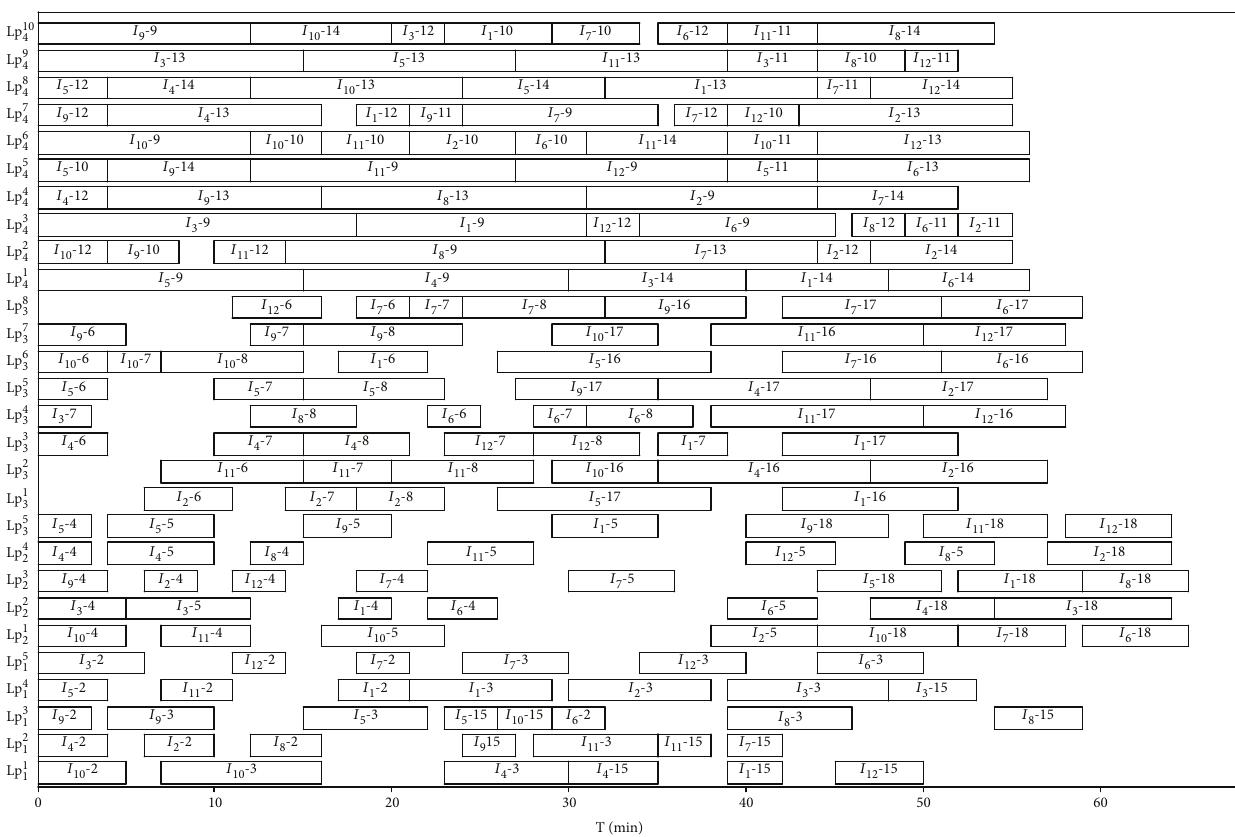
Figure 14: Gantt chart of robust personnel allocation.